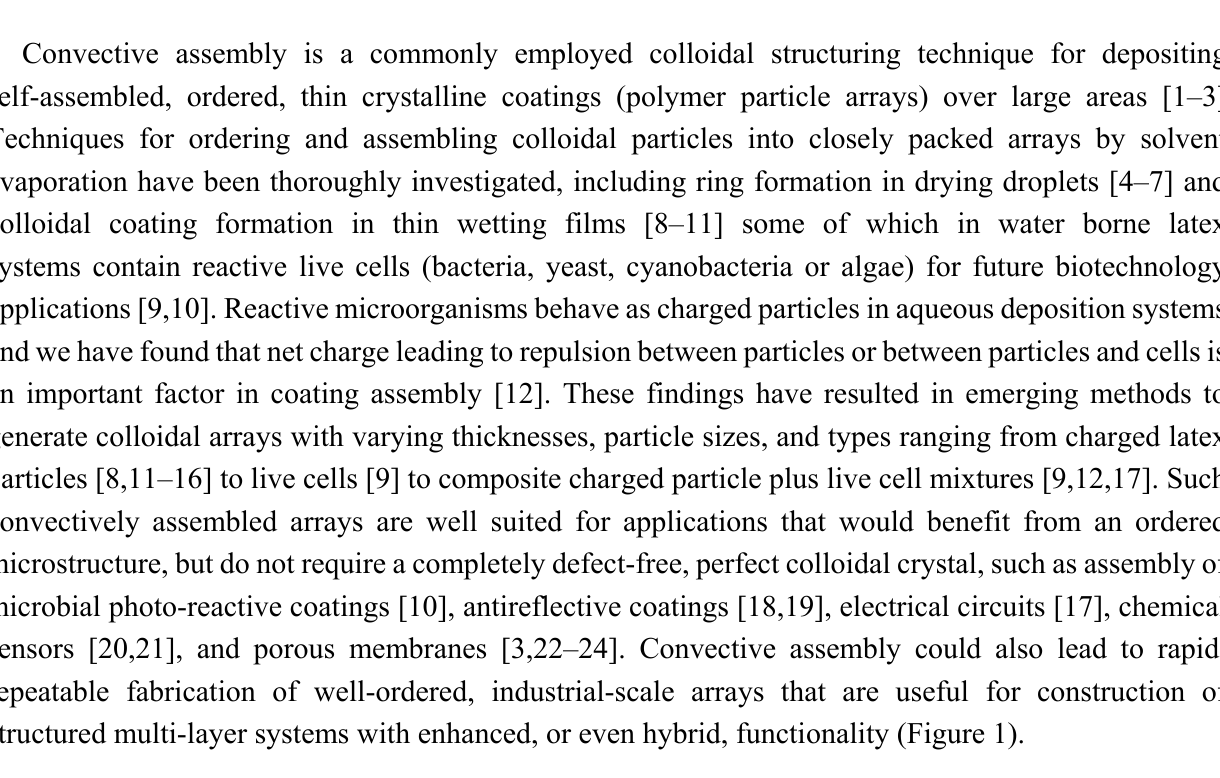
Figure 1. Schematic of coating microstructures that could be deposited using sequential convective assembly of particle monolayers to form multilayer, composite bioreactive devices. Each color represents a different type of particle or cell. Each new layer is deposited after the underlying layer has dried under controlled temperature and relative humidity